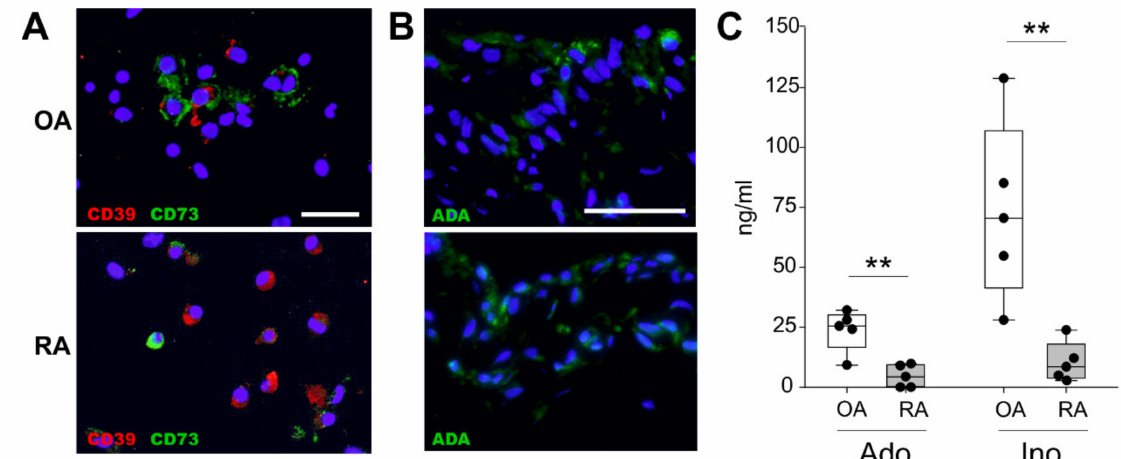
Figure 1. CD39/CD73 expression, ADA expression, and adenosine/inosine release. ( A ) Representative fluorescent mi- crographs of OA and RA mixed synoviocytes immunostained for CD39 (red) and CD73 (green) and counterstained nuclei with DAPI (blue) (bar: 25 µ m). ( B ) Representative fluorescent micrographs of OA and RA mixed synoviocytes immunostained for ADA (green) and counterstained nuclei with DAPI (blue) (bar: 50 µ m). ( C ) Quantification of spon- taneous adenosine and inosine release in OA and RA mixed synoviocytes. Data are represented as box plots, where the boxes represent the 25th to 75th percentiles, the lines within the boxes represent the median, and the lines outside the boxes represent the 10th and 90th percentiles. Each black circle represents the synovial cells of an individual patient (n = 5). Significant p -values are presented as ** p ≤ 0.01. Abbreviations: ADA—adenosine deaminase; Ado—adenosine; DAPI—4 (cid:48) ,6-diamidino-2-phenylindole; Ino—inosine; OA—osteoarthritis; RA—rheumatoid